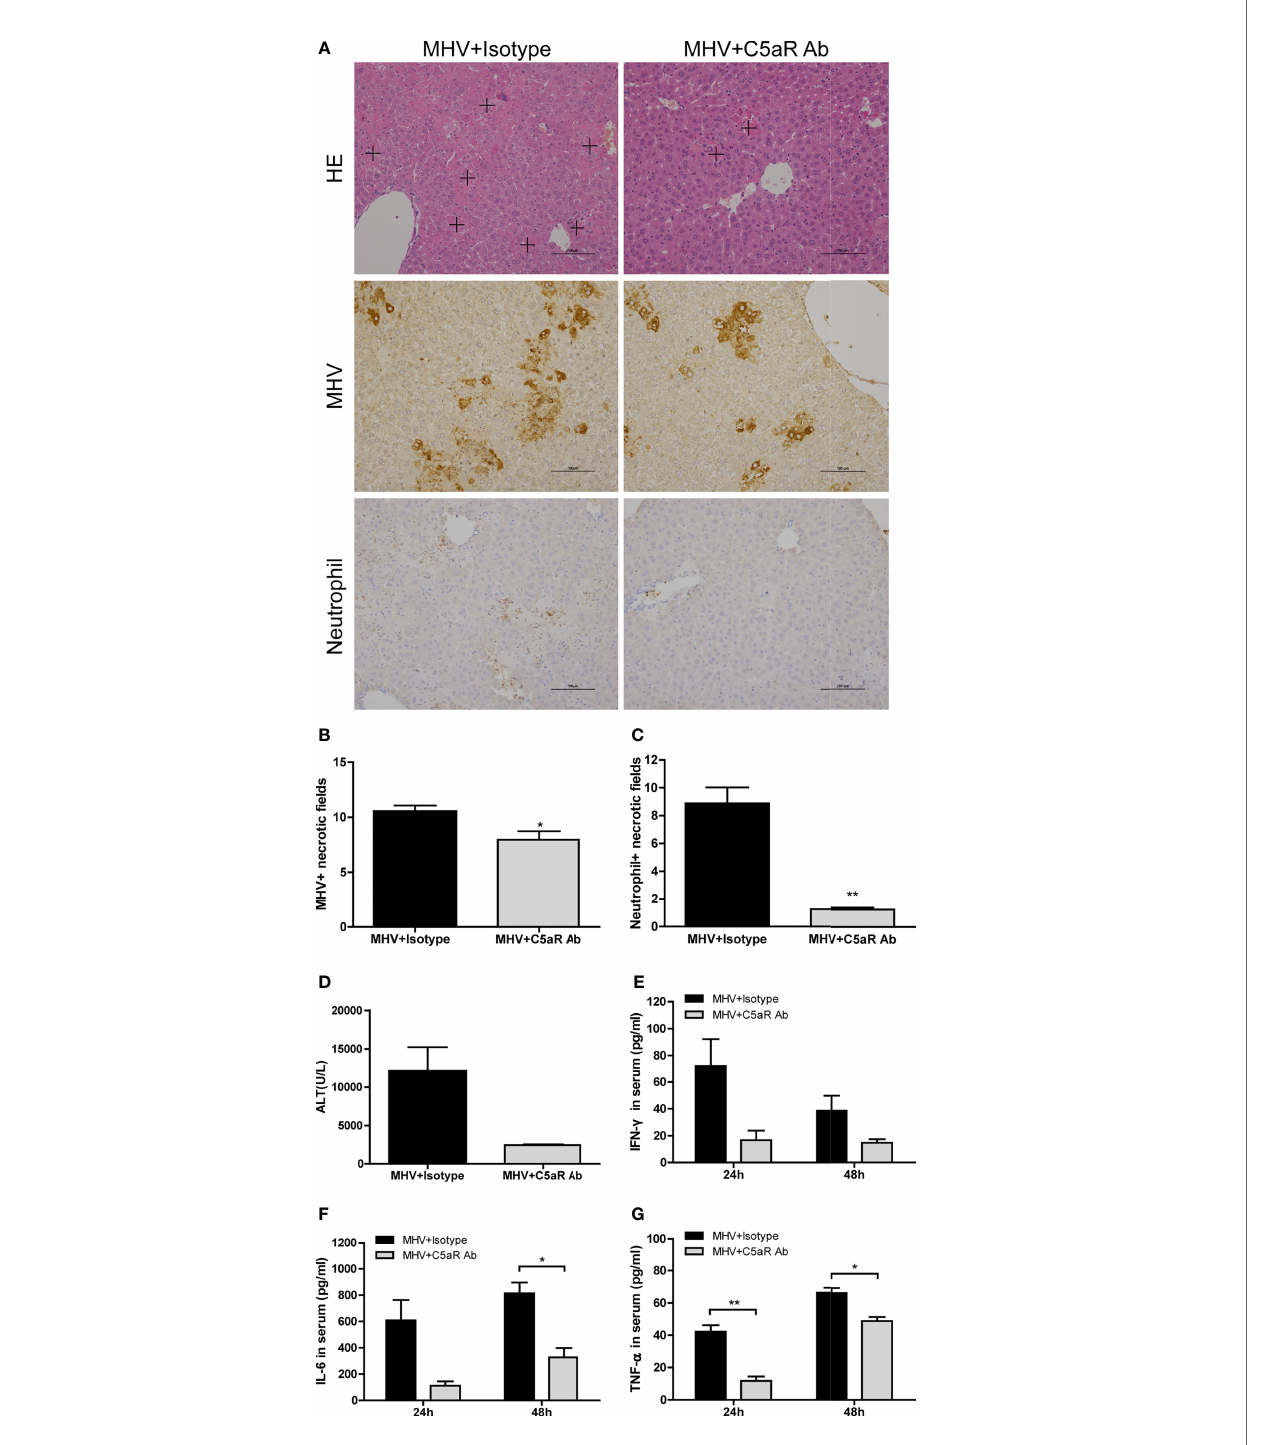
FIGURE 5 | Attenuated liver damage in mice treated with anti-C5aR antibody after MHV-3 infection. Mice were administered anti-C5aR antibody or the isotype antibody 12 hrs after MHV-3 infection and euthanized, and liver tissue and serum samples were collected. (A) Histological examination of liver tissue, and immunohistochemical staining for viral antigen and neutrophil in fi ltration in mouse livers 48 h after virus infection (cross, multifocal damage area). (B, C) Semiquantitative assessment of viral antigen and neutrophil in fi ltration in livers 48 hrs after virus infection. (D) Serum ALT concentrations 48 hrs after virus infection. (E – G) Serum concentrations of proin fl ammatory cytokines 24 and 48 hrs after MHV-3 challenge. These results are representative of three independent experiments with similar results (n = 3-4 per group). * p <0.05, ** p <0.01 compared with the isotype control. Original magni fi cation, ×